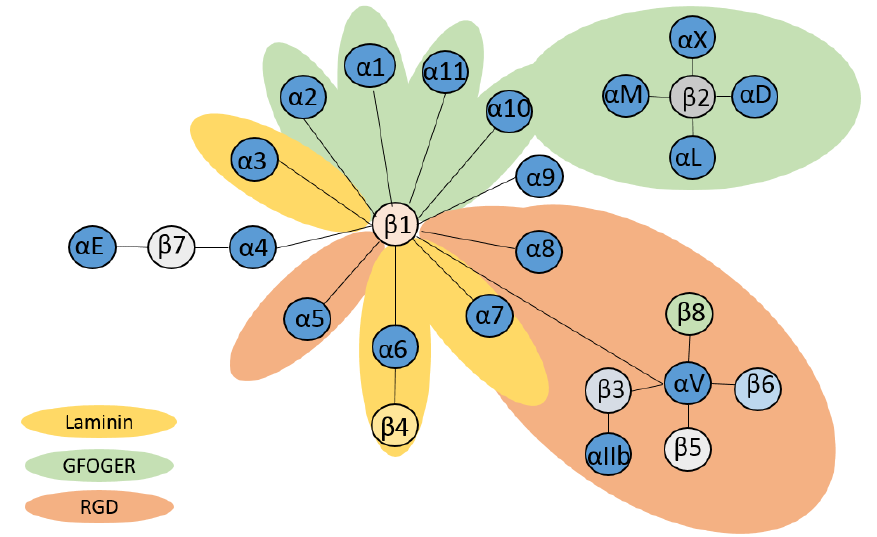
Figure 1. Representative members of integrins in vertebrates and their binding specificity.